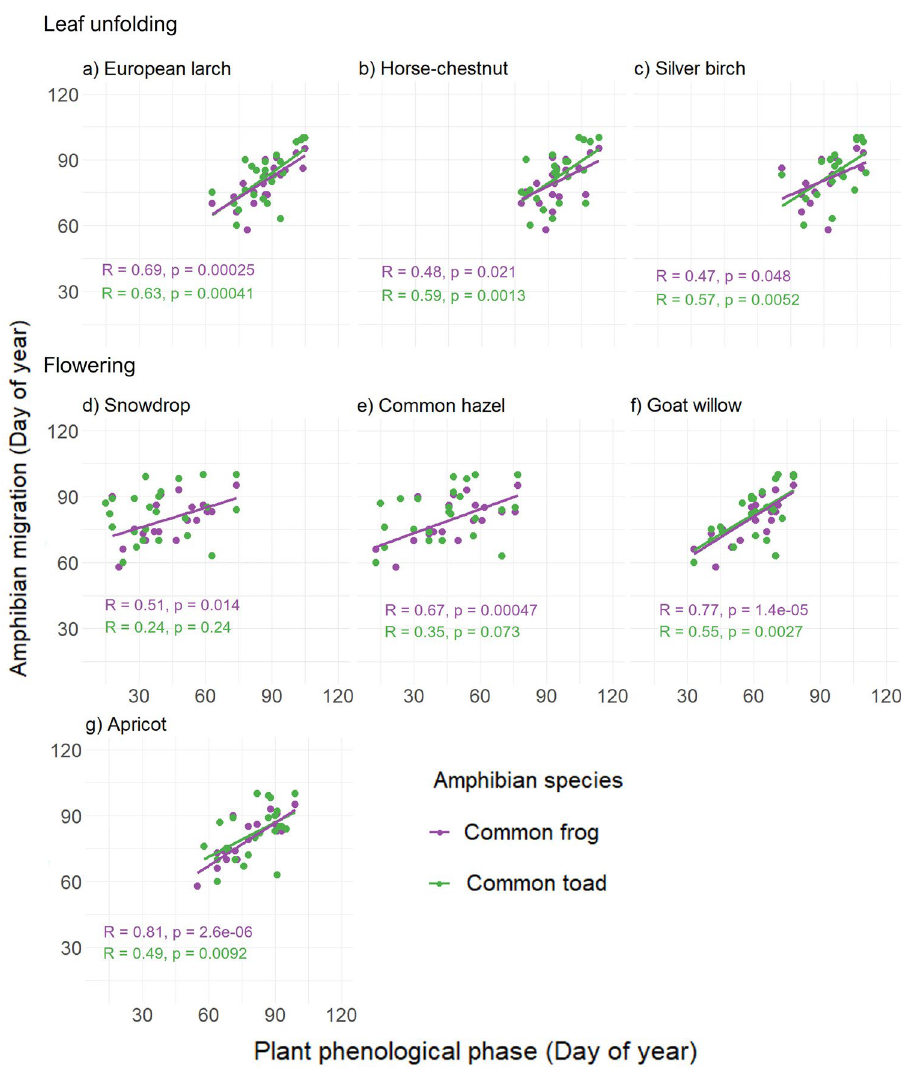
Figure 3. Correlations between the start of the migration of common toads and common frogs and onset of leaf unfolding of European larch ( a ), horse-chestnut ( b ), silver birch ( c ) and start of flowering of snowdrop ( d ), common hazel ( e ), goat willow ( f ) and apricot ( g